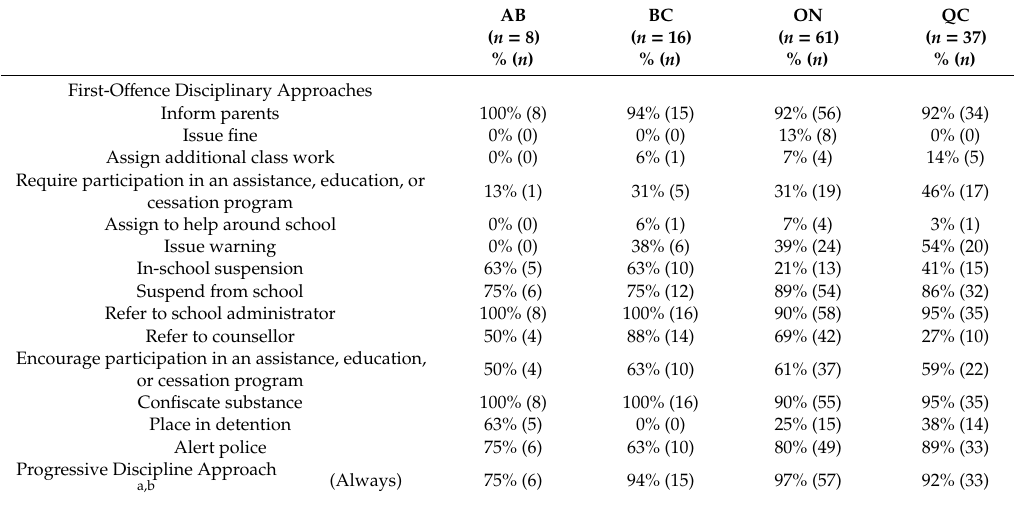
Table 2. Frequency of various disciplinary approach options selected by secondary schools ( n = 122) as being used in response to student violations of school cannabis policies in Year 6 (2017/2018) of the COMPASS study.